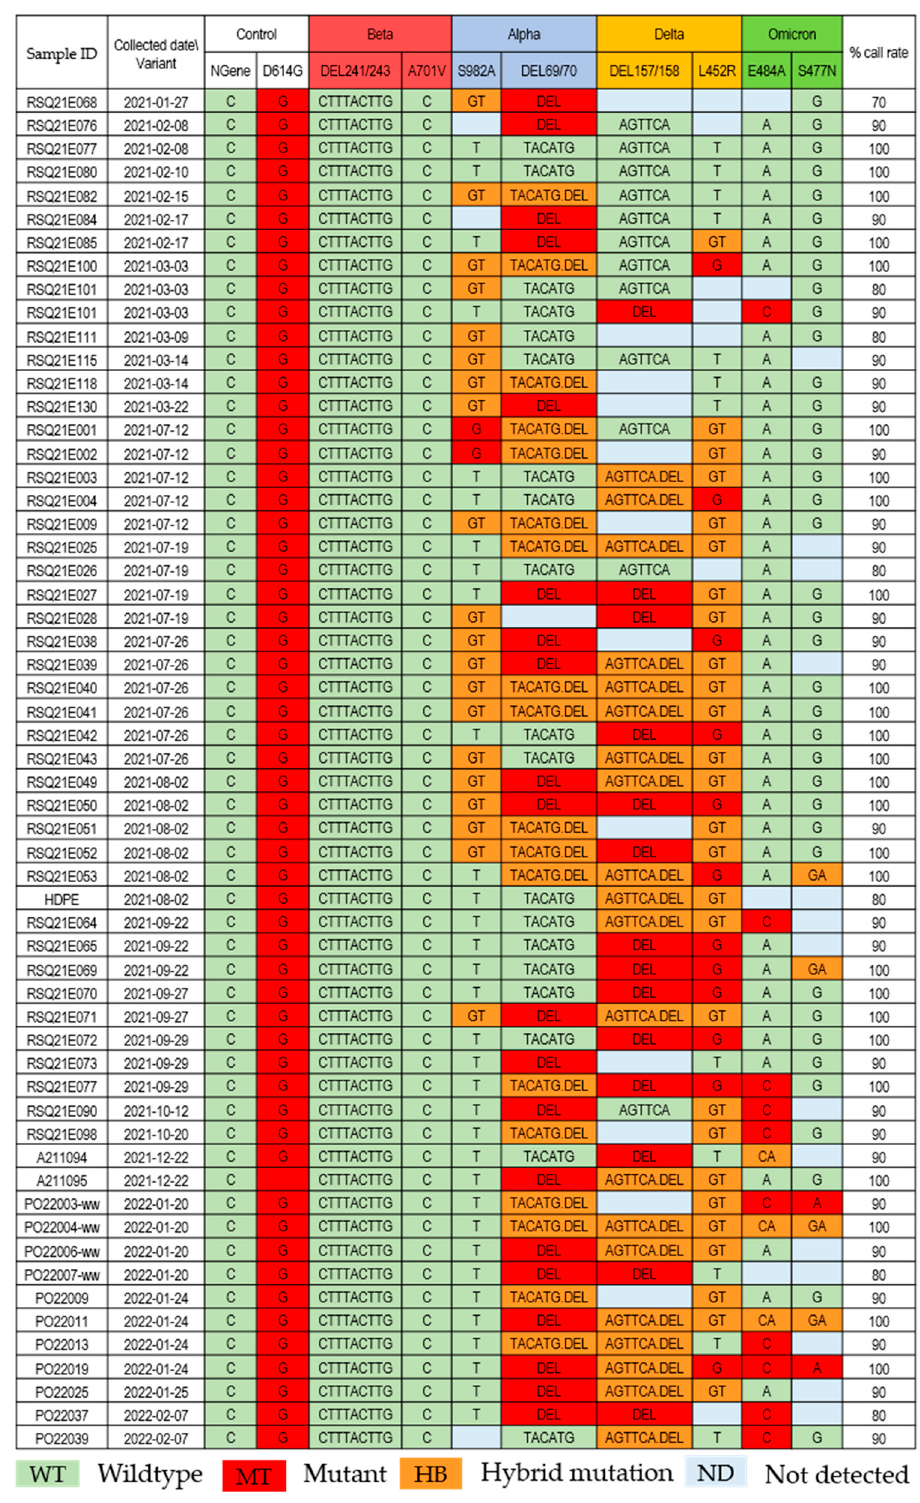
Figure 2. Fifty-eight wastewater sample test results were assessed for four SARS-CoV-2 variants using multiplex PCR MassARRAY assay (PMA). Variant identification by PMA at eight specific sites of the spike gene for differentiating SARS-CoV-2 variants: Alpha (S982A, DEL69/70), Beta (DEL241/243, A701V), Delta (DEL157/158, L452R), and Omicron (E484A, S477N), and two control genes (N and D614G).